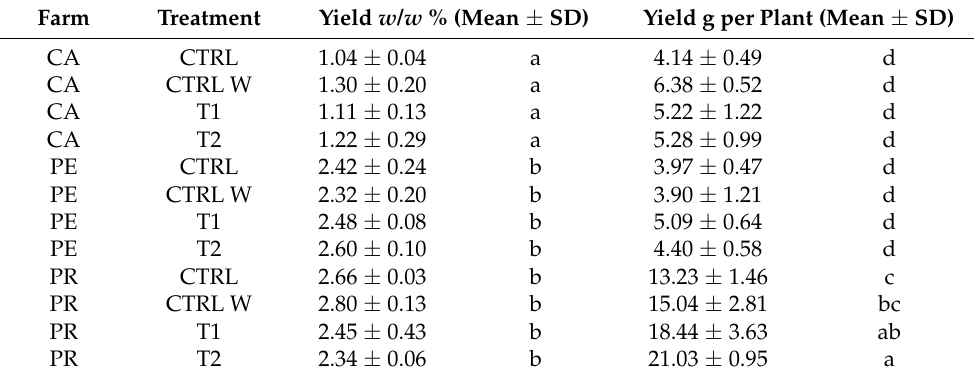
Table 1. The yields of the steam distilled essential oils (mean ± standard deviation of each sample group, n = 3) expressed as percentages ( w/w ) and g per plant. Distinct letters were used to differentiate statistically different groups according to Tukey’s post-hoc test ( p < 0.05).